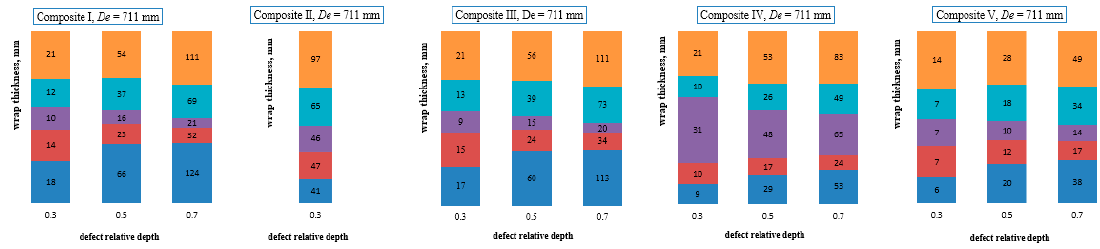
Figure 9. Summary of the results for case study no. 2 (from [21]).